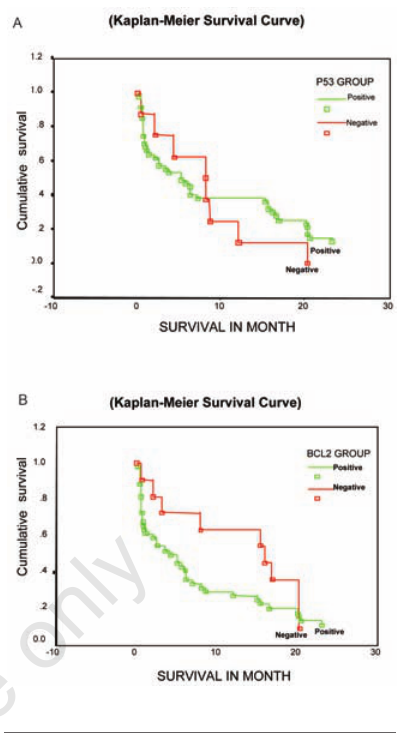
Figure 1. (A) Kaplan-Meier survival curve showing survival functions with p53 posi- tive versus p53 negative. (B) Kaplan-Meier survival curve showing survival functions with Bcl-2 positive versus Bcl-2 negative.